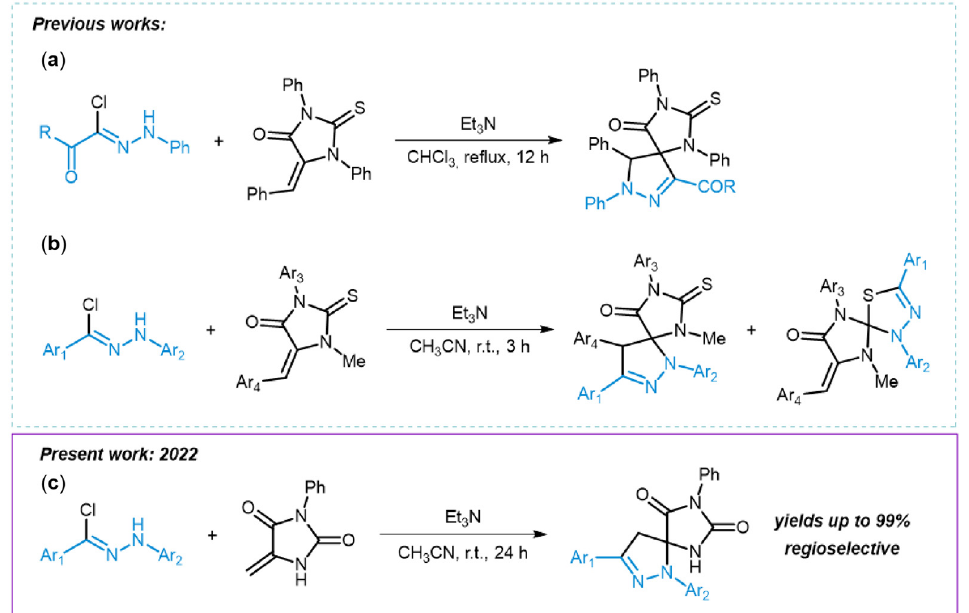
Scheme 1. Synthetic approaches to the regioselective 1,3-dipolar cycloaddition reaction of nitrile imines to thiohydantoins and hydantoin derivatives. ( a , b ) previous works [16,17]; ( c ) present work.